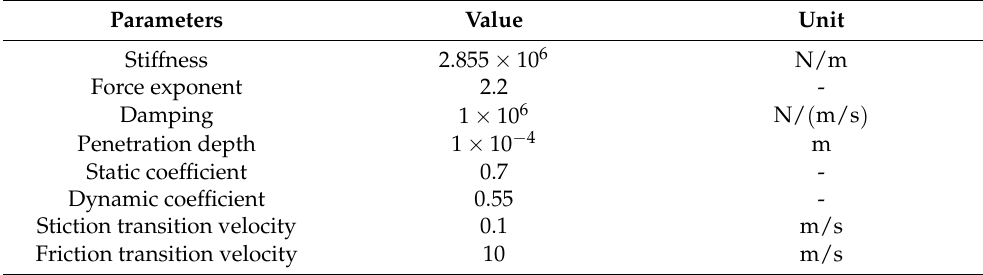
Table 3. Ground contact parameters in ADAMS.